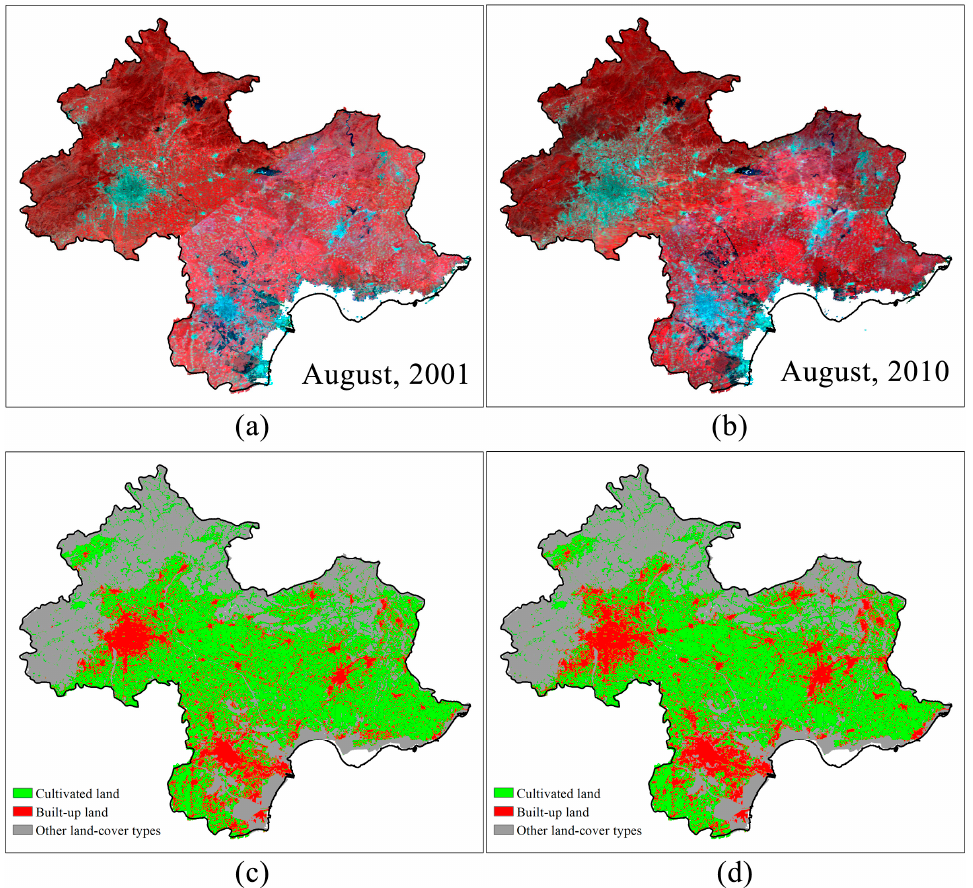
Figure 13. MODIS pseudo-color composite images and corresponding land-cover maps for 2001 and 2010 generated from the proposed algorithms. ( a , b ) MODIS 250 m images acquired in August 2001 and August 2010, respectively; ( c , d ) the produced land-cover maps.